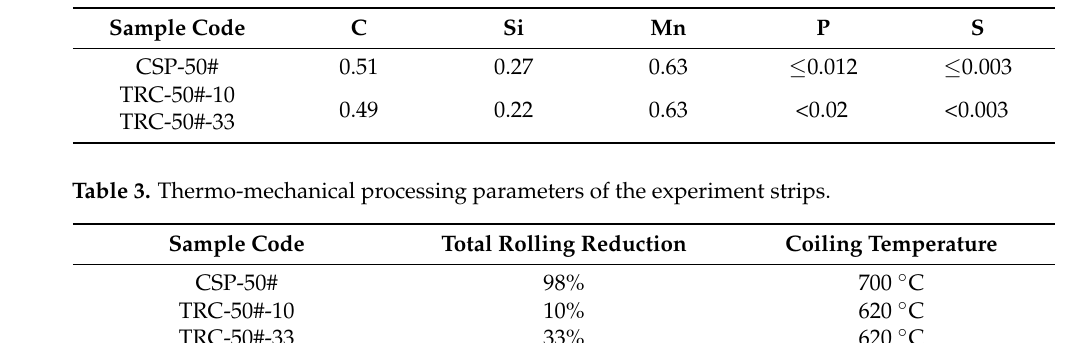
Table 2. Chemical compositions of the investigated CSP-50#, TRC-50#-10 and TRC-50#-33 strips (wt.%).